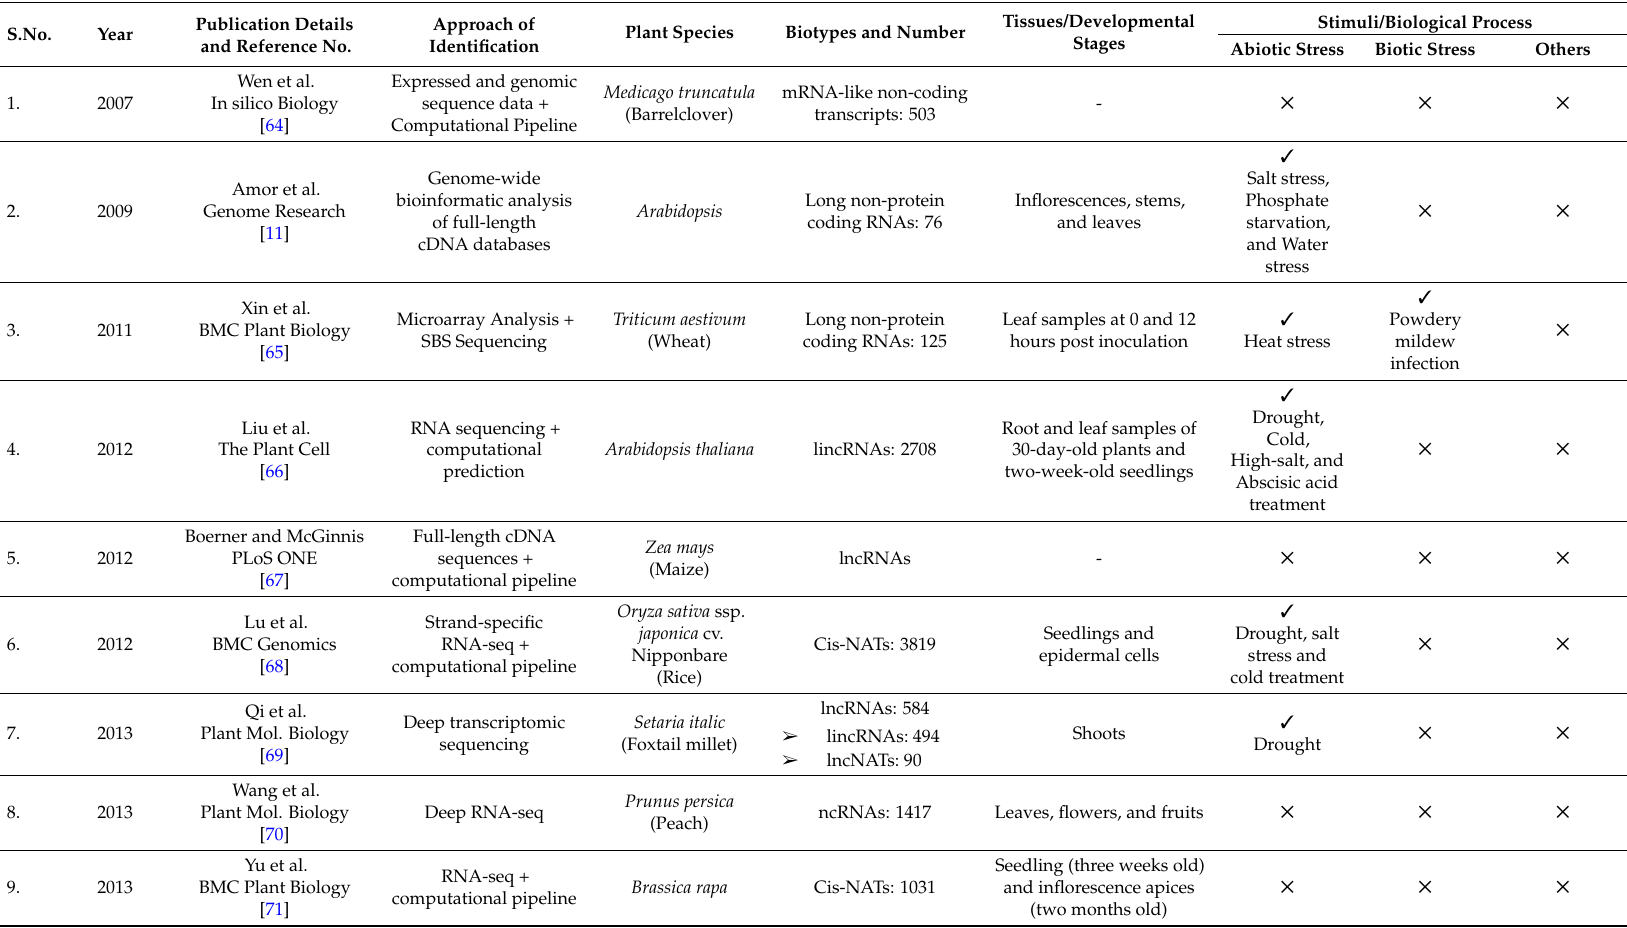
Table 1. Studies showing genome-wide identification of long non-coding RNAs (lncRNAs) in plants over the last decade.